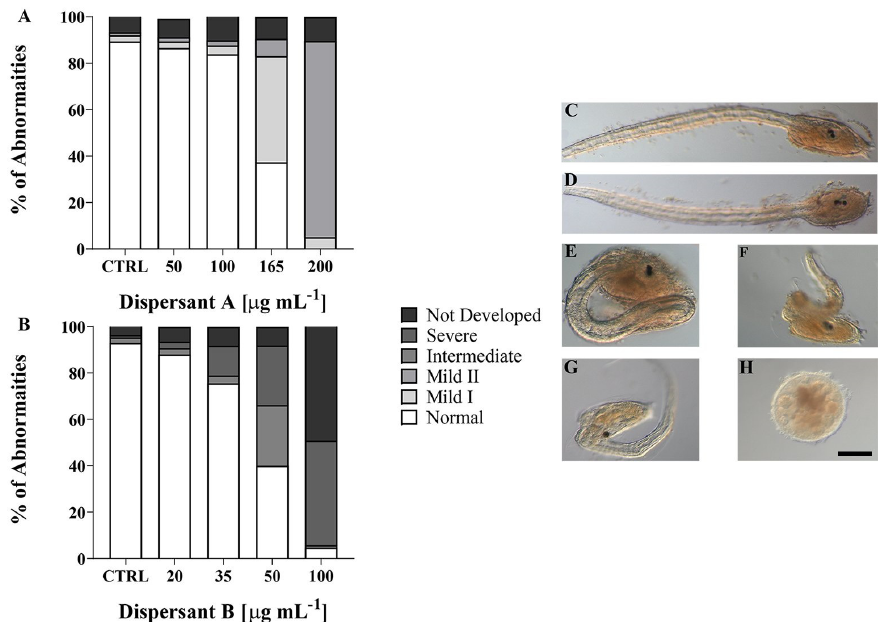
Figure 2. ( A ) Percentages (%) of total abnormalities identified upon exposure to dispersant A; ( B ) percentages (%) of total abnormalities identified upon exposure to dispersant B. Bars represent mean ± SD ( n = 1080); light microscopy images of the different phenotypes obtained upon exposure to dispersant A and dispersant B. ( C ) Control; ( D ) Mild I phenotype; ( E ) Mild II phenotype; ( F ) Intermediate; ( G ) Severe; ( H ) Not Developed embryo. Scale bar: 50 μ m.